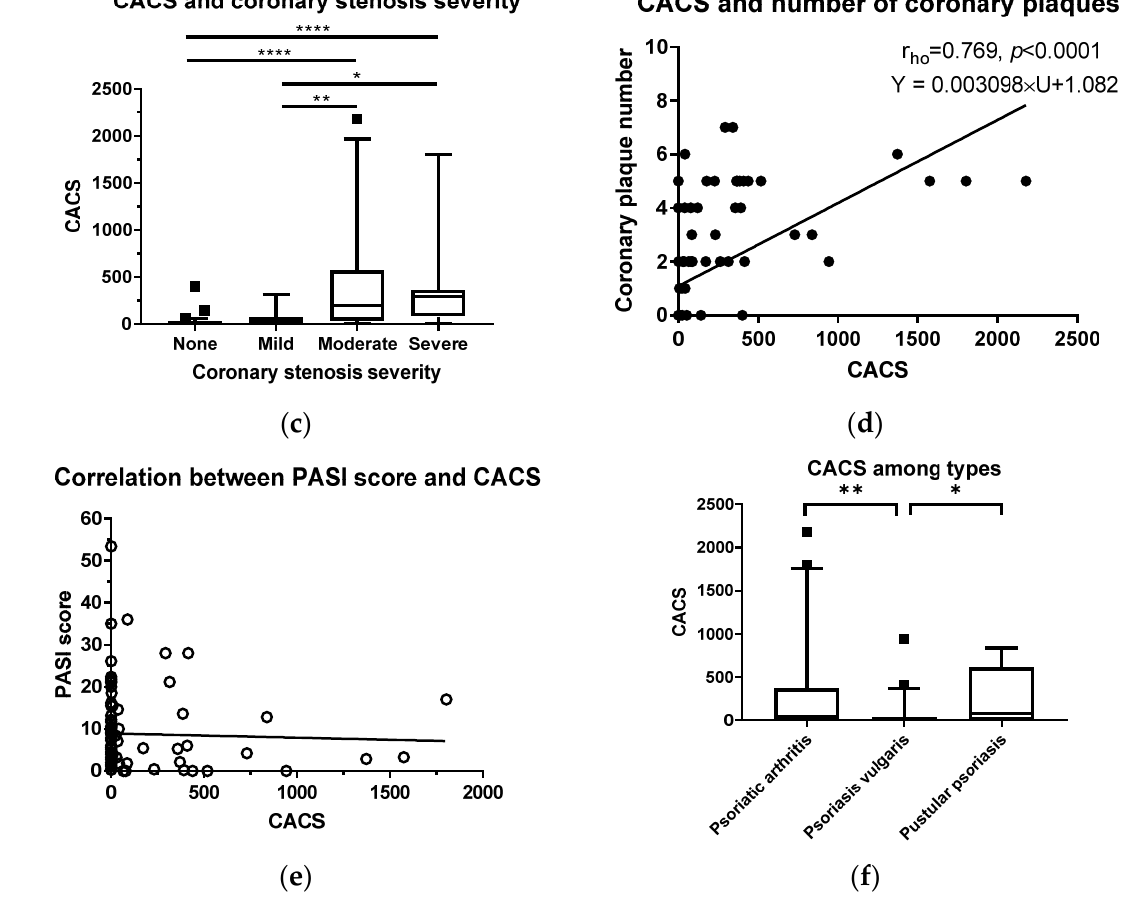
Figure 3. ( a – f ): The association between CCTA and CACS. (with *: p < 0.05, **: p < 0.01, ***: p < 0.001, ****: p < 0.0001) ( (cid:4) CACS values exceeded 95th percentile of those subgroups; • CACS value and the respective coronary plaque number; CACS values and the respective PASI score).